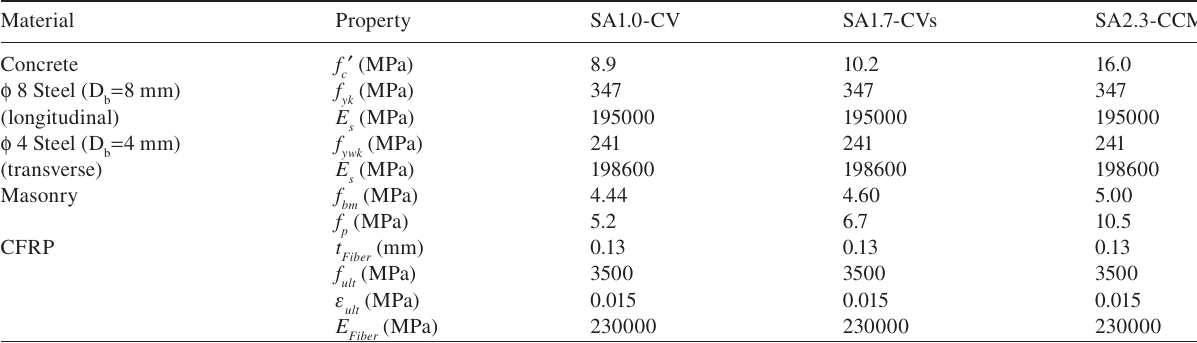
Table 1 Material properties.